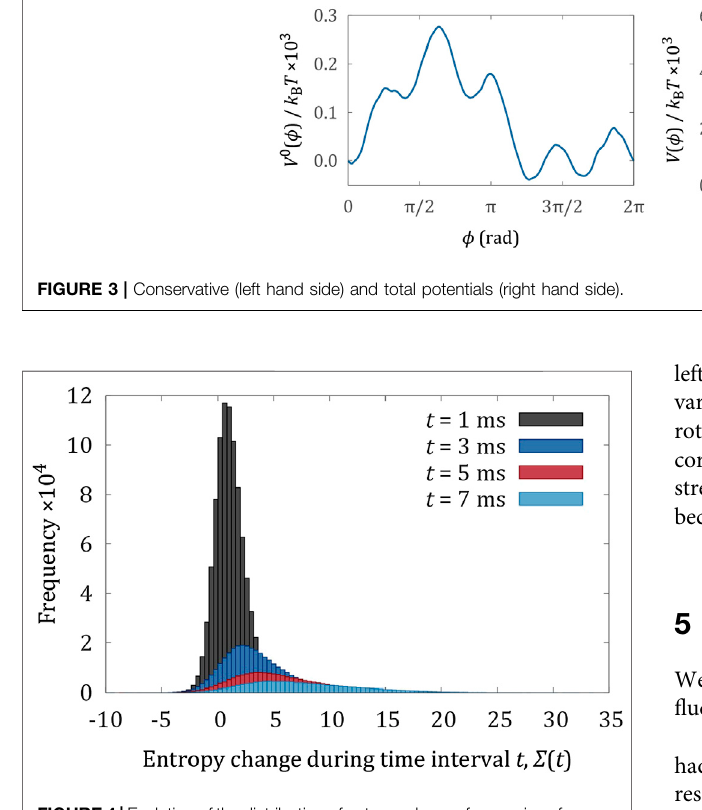
showing negative changes in entropy. As the time interval lengthens, the distribution spreads out, and the peak shifts to higher positive values. At each stage the fraction of trajectories showing negative entropy change decreases. This process is quanti fi ed by the transient and integrated rotational FTs, which are tested in Figure 5 . On the left hand side, Figure 5A we plot the logarithm of Eq. 1 . In accordance with the FT, the graph is a linear one passing through the origin. The gradient of the best fi t line is 1.14, compared with 1, as it would be for perfect agreement. The integrated form is tested by plotting the right and